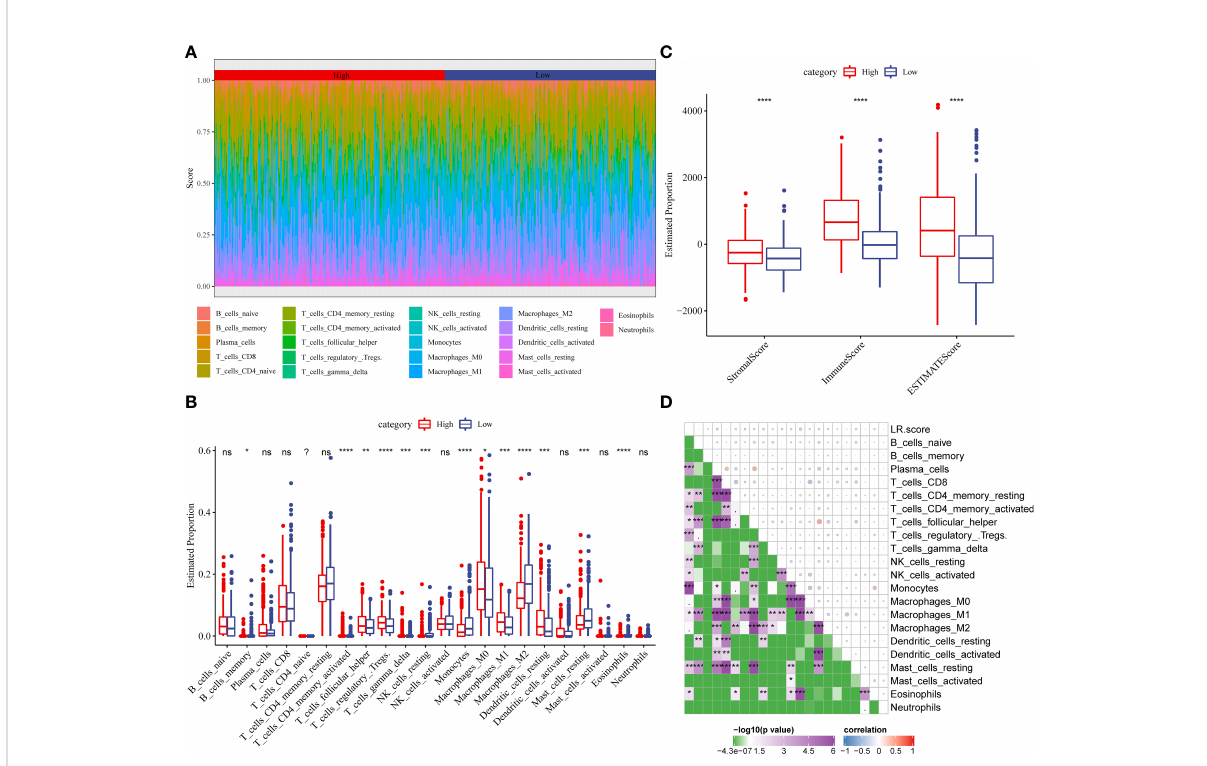
FIGURE 10 (A) Score of 22 immune cell in fi ltration in different LR.score groups. (B) Proportion of 22 immune cell in fi ltration in different LR.score groups. (C) Differences in the distribution of immune cell scores in different LR.score groups. (D) Correlation between LR.score and 22 immune